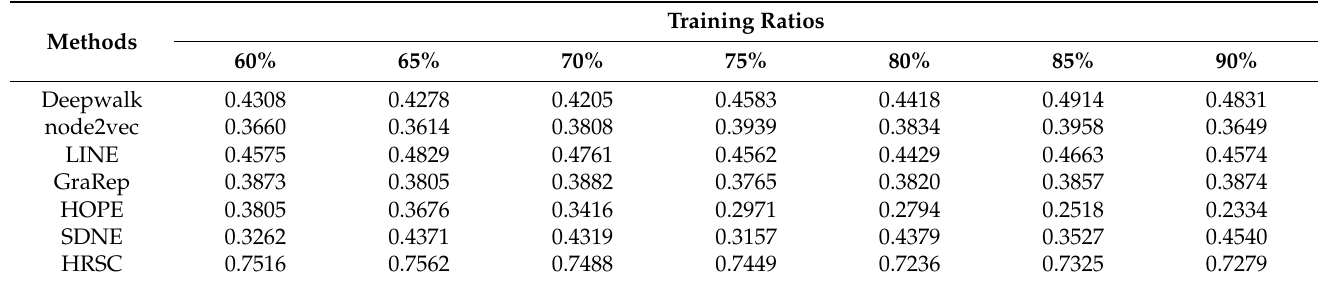
Table 5. AUC values on GPS.